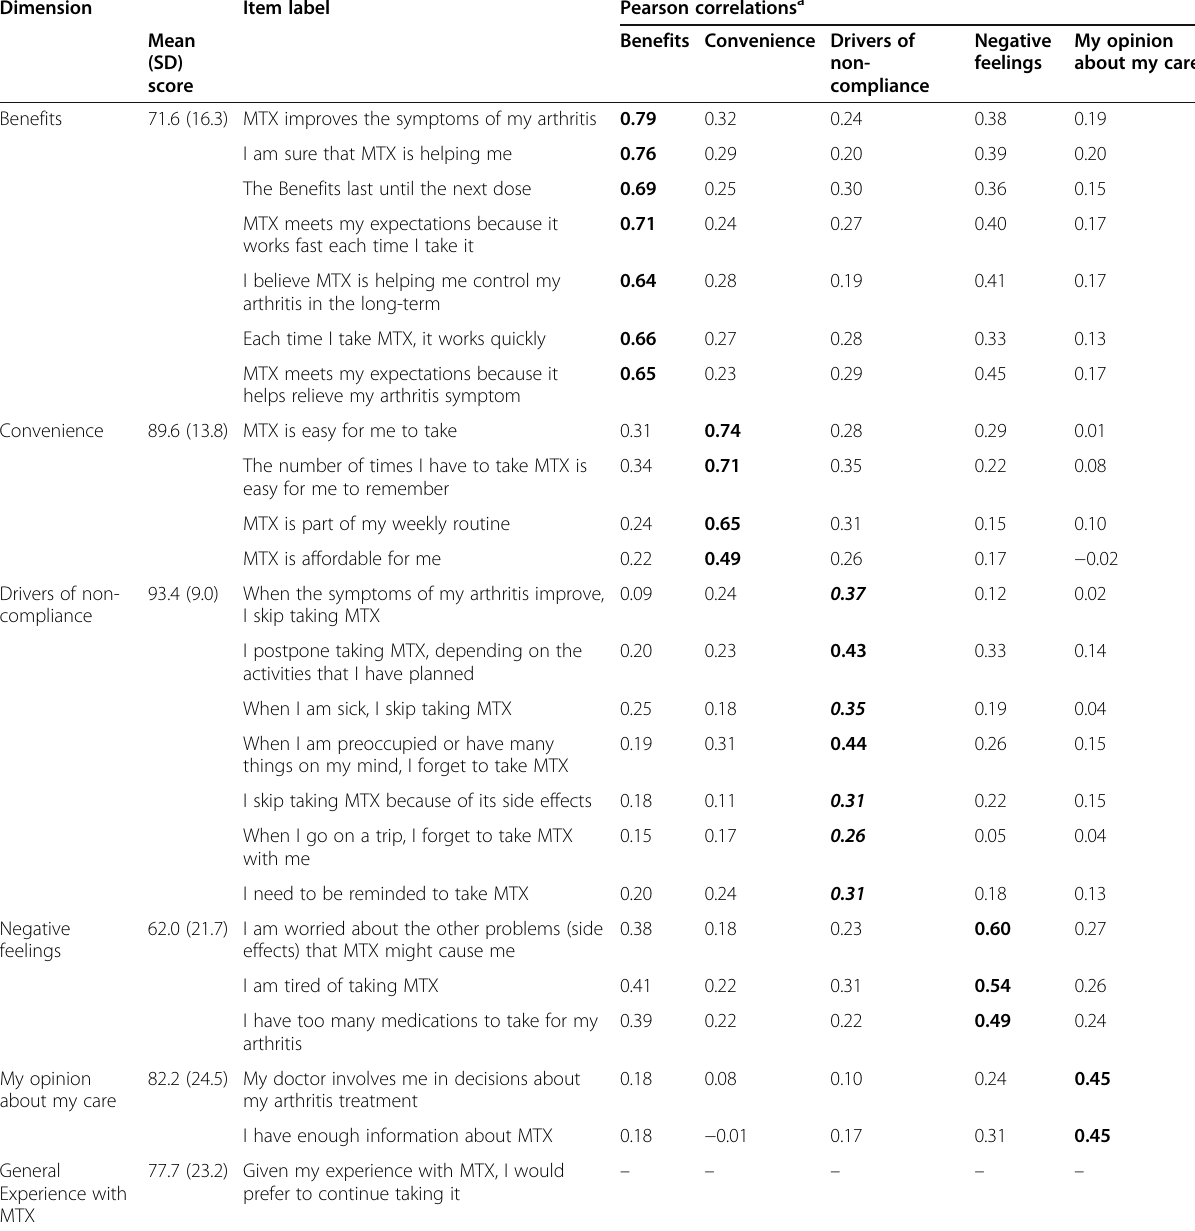
Table 2 Final structure of the MEQ and item-scale Pearson correlations from the multitrait analysis Dimension Item label Pearson correlations